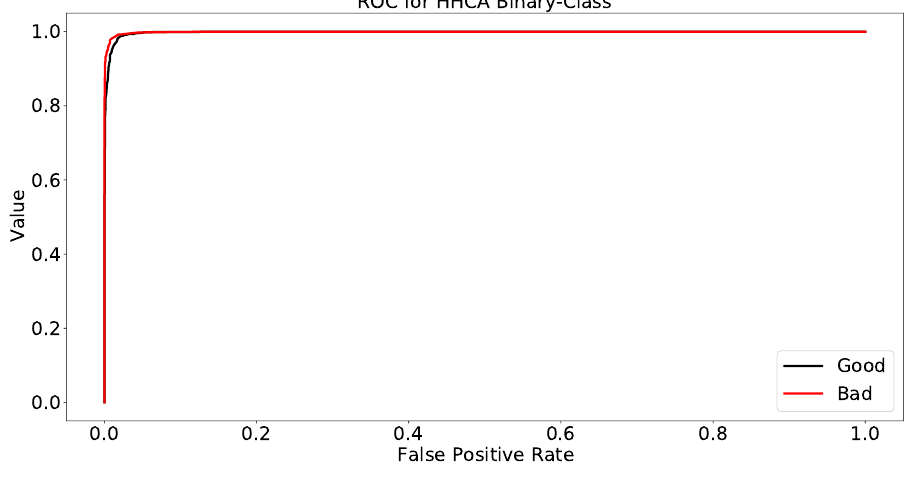
Figure 2. ROC for HHCA binary